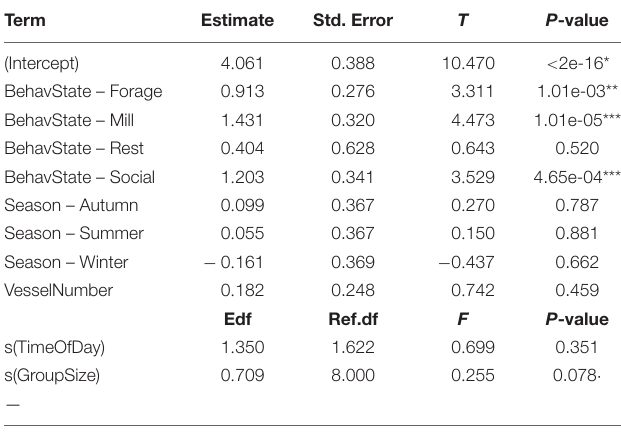
TABLE 6 | Summary of output for best fitting model for Indo-Pacific humpback dolphin reorientation rate.